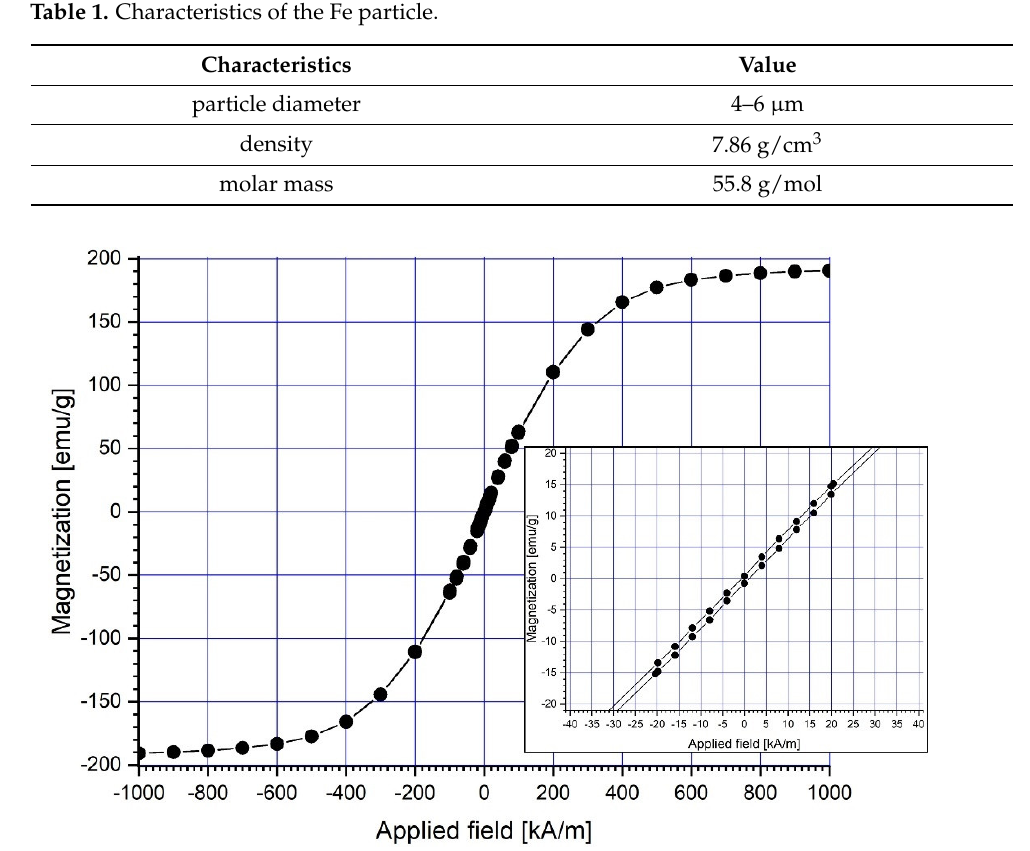
Table 1. Characteristics of the Fe particle. Figure 2. Morphology of the 4–6 μm Fe powder as seen in a microscopic picture.